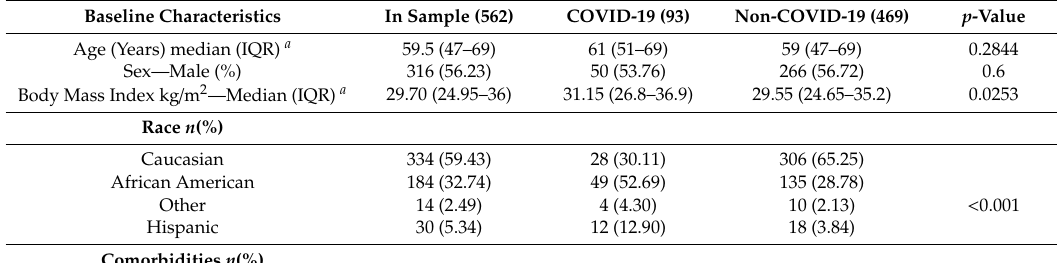
Table 1. Baseline characteristics, respiratory support, and medication